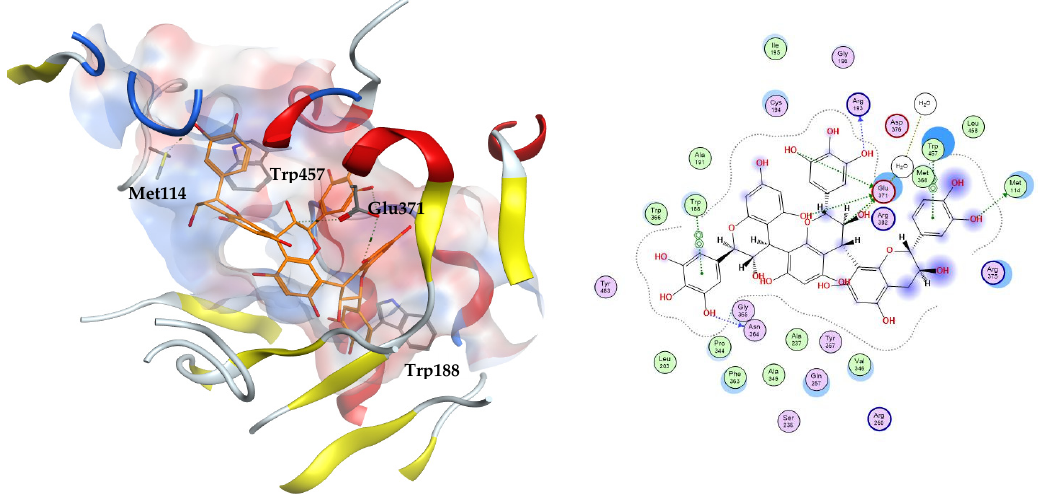
Figure 4. The 3D ( left ) and 2D ( right ) interactions of prodelphinidin C2 with iNOS binding cavity.